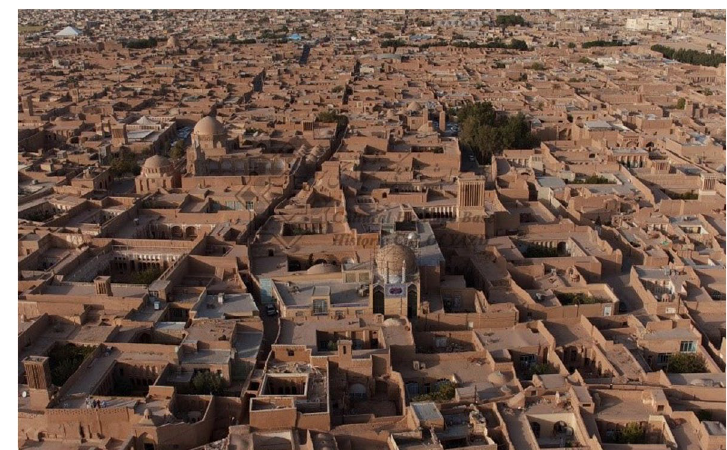
Fig. 1 Aerial view of the historic fabric of Yazd (Source: S.H.